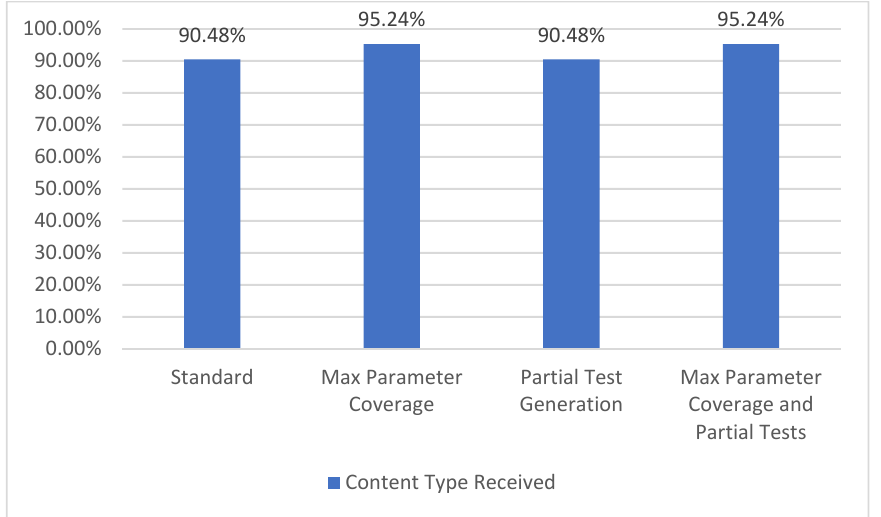
Figure 13. Content type coverage.